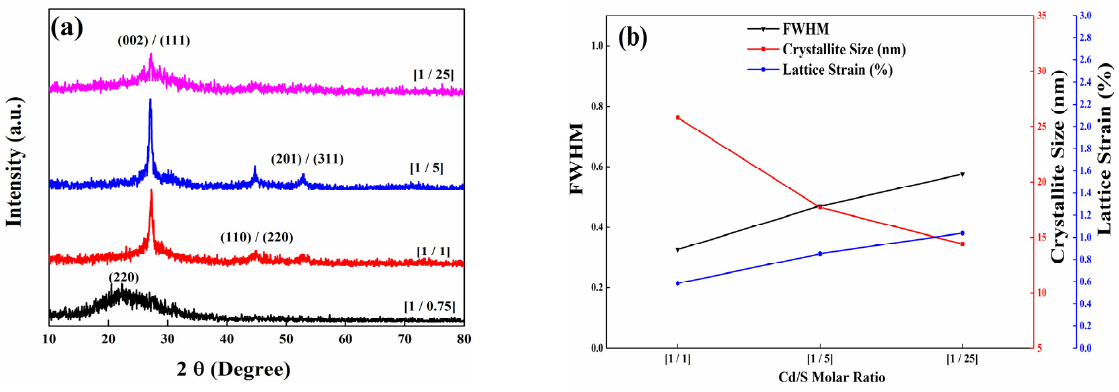
Figure 3. ( a ) XRD for [Cd]/[S] ratios, ( b ) FWHM, Lattice strain, crystalline size vis [Cd]/[S] molar ratio.